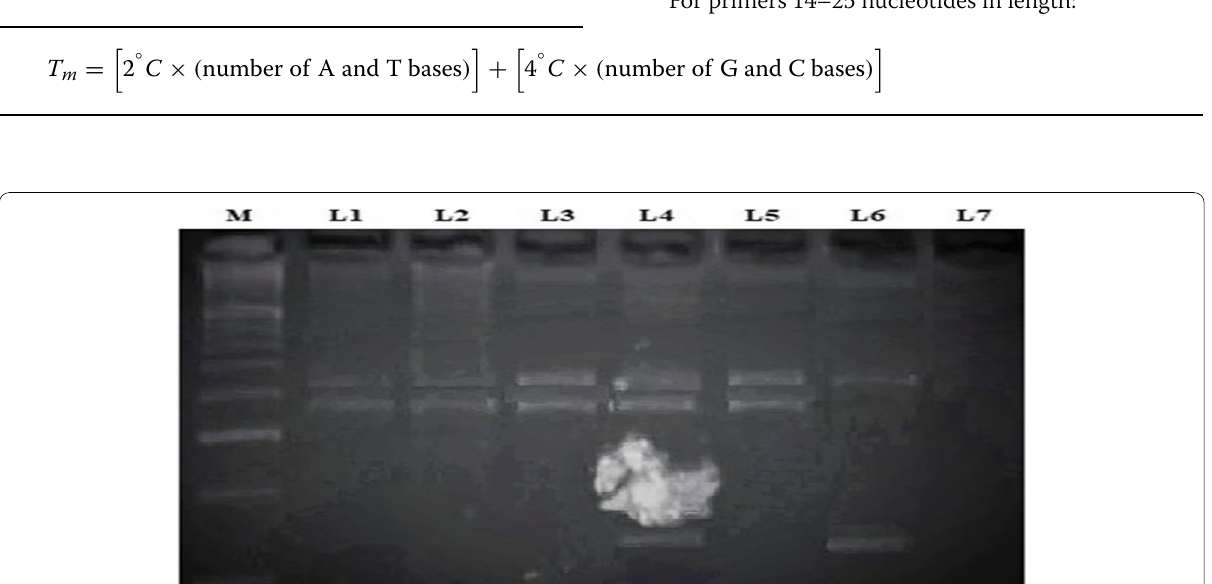
Fig. 2 Representative picture of ARMS-PCR products for detection of 15 bp deletion in exon 19 of EGFR gene . A single tube reaction in which “M” contains molecular marker (100 bp); L1, L2, L3, and L4 contain 444 bp and 325 bp bands representing absence of deletion; L6 contains 444 bp and 134 bp bands representing the presence of 15 bp deletion; L4 and L6 contain 444 bp, 325 bp, and 134 bp bands representing the heterozygosity; L7 represents negative